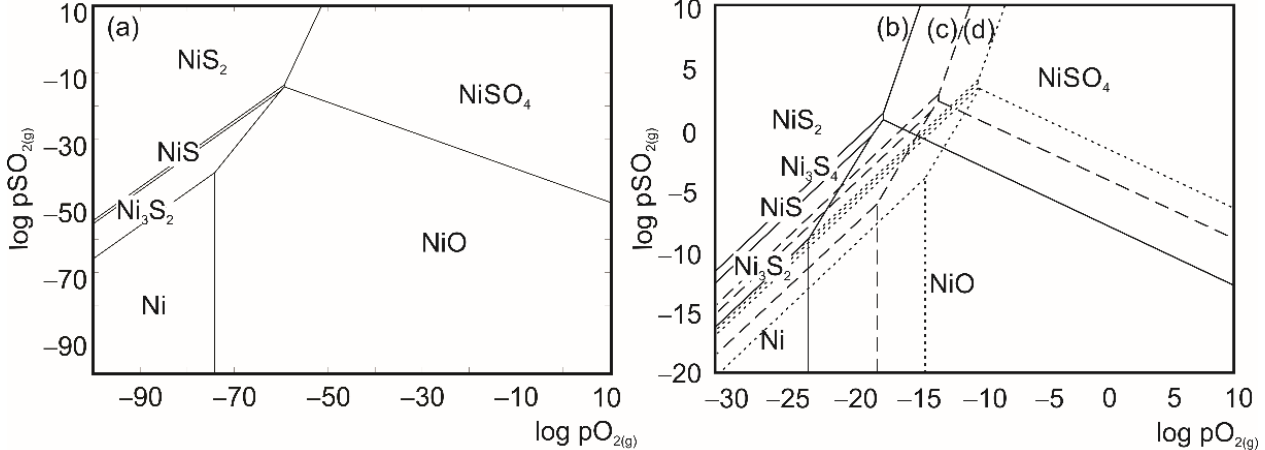
Figure 3. Kellogg diagrams constructed for Ni ‐ S ‐ O system at ( a ) 298 K, ( b ) 773 K, ( c ) 923 K and ( d ) 1073 K [37,38].